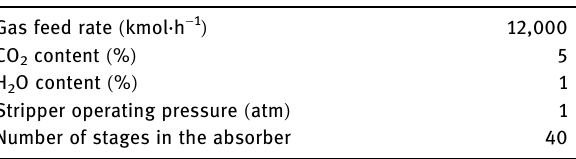
Table 1: Baseline operating condition for the CO 2 capture process [ 53 ]